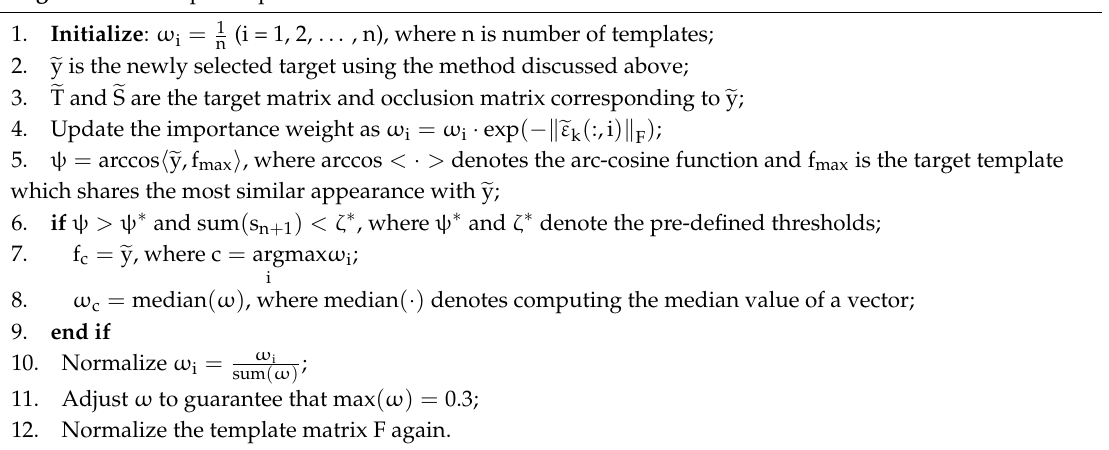
Algorithm 2. Template update